Question: Express in one sentence what the figure is showing.
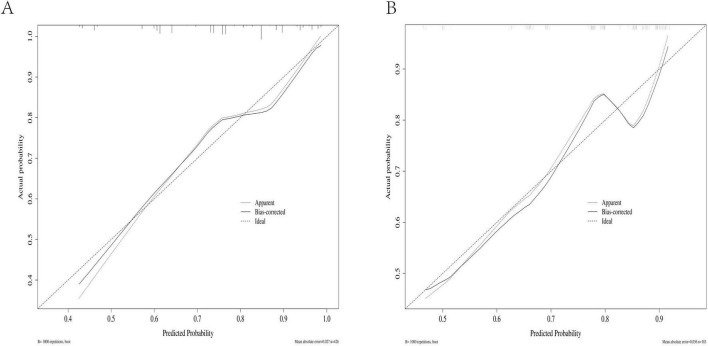
Answer: Calibration curves for the nomogram model in the training groups (A) and the validation groups (B) .